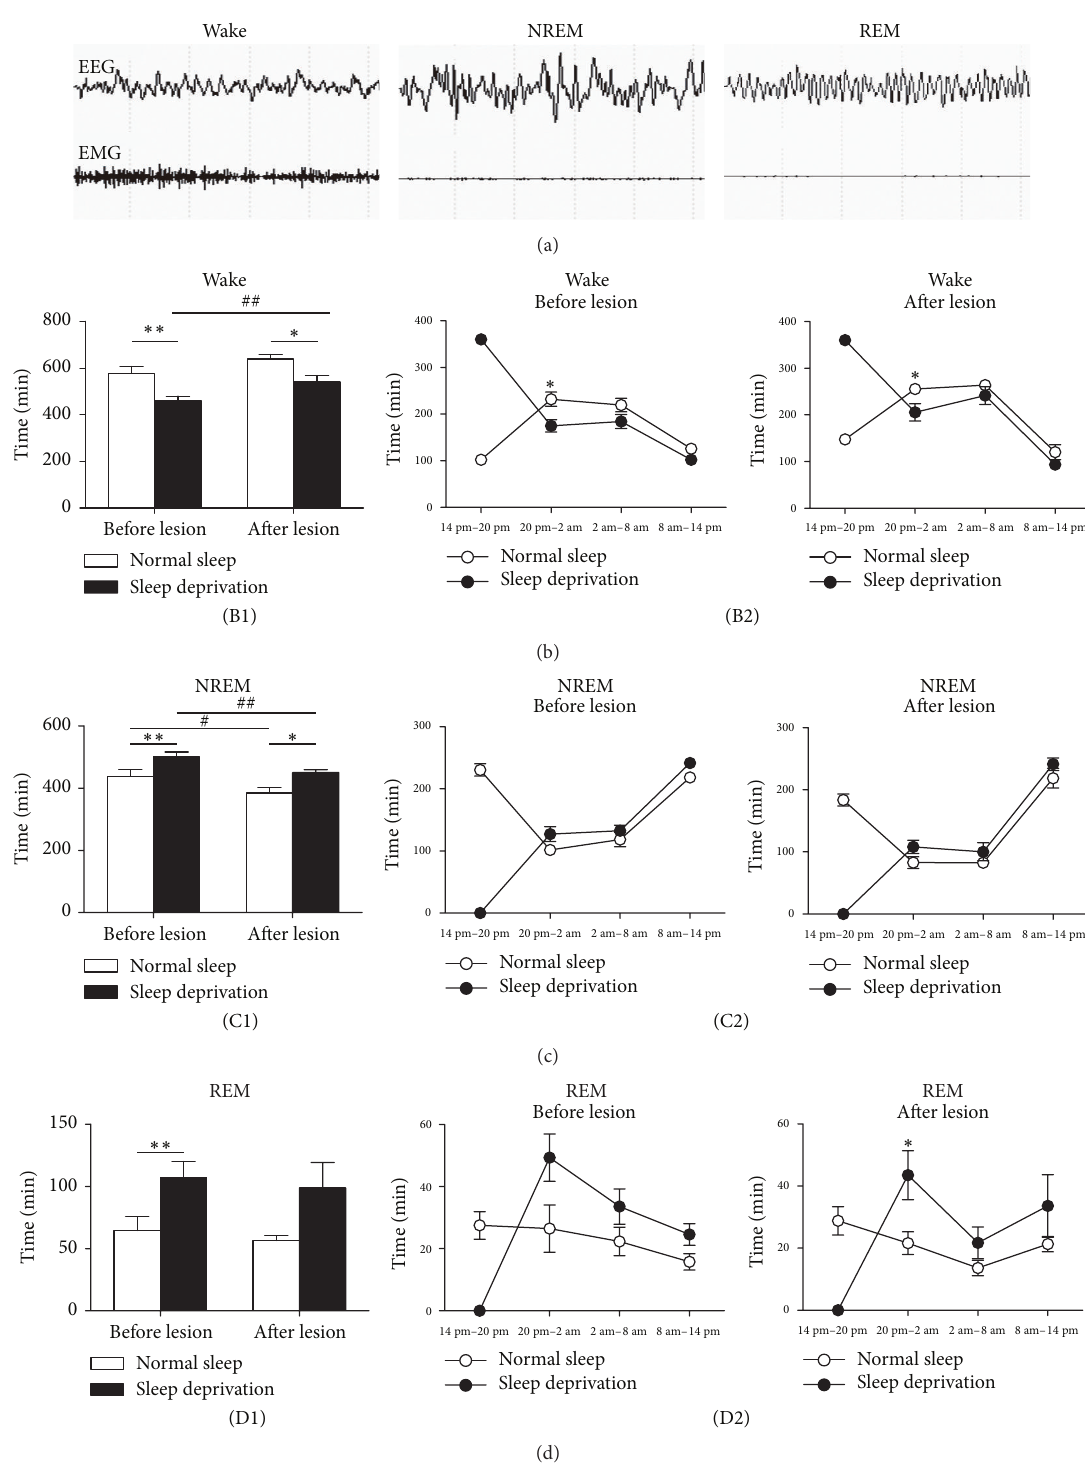
Figure 2: The effect of LHb lesion on sleep-wake times following sleep deprivation in rats. (a) indicates the typical EEG and EMG recording, respectively,forwake,NREMS,andREMStimes.ThewakestatewasidentifiedbythepresenceofdesynchronizedEEGandhighEMGactivity. The NREMS consisted of high-amplitude slow waves together with a low EMG relative to awake. The REMS was identified by the presence of regular 𝜃 activity coupled with low EMG relative to NREMS. (B1), (C1), and (D1), respectively, show the wake, NREMS, and REMS times following sleep deprivation before and after LHb lesion. Data from 18h EEG recording were analyzed and presented as means ± SEM ( 𝑛 = 6 ). ∗ 𝑃 < 0.05 , ∗∗ 𝑃 < 0.01 , compared, respectively, difference between the wake, NREMS, and REMS times before and after sleep deprivation. # 𝑃 < 0.05 , ## 𝑃 < 0.01 , compared, respectively, difference between the wake and NREMS times following deprivation before and after LHb lesion. (B2), (C2), and (D2) show, respectively, the graphs of wake, NREMS, and REMS plotted per 6 h for a 24 h period before and after lesion. ∗ 𝑃 < 0.05 compared with sleep deprivation at the same time